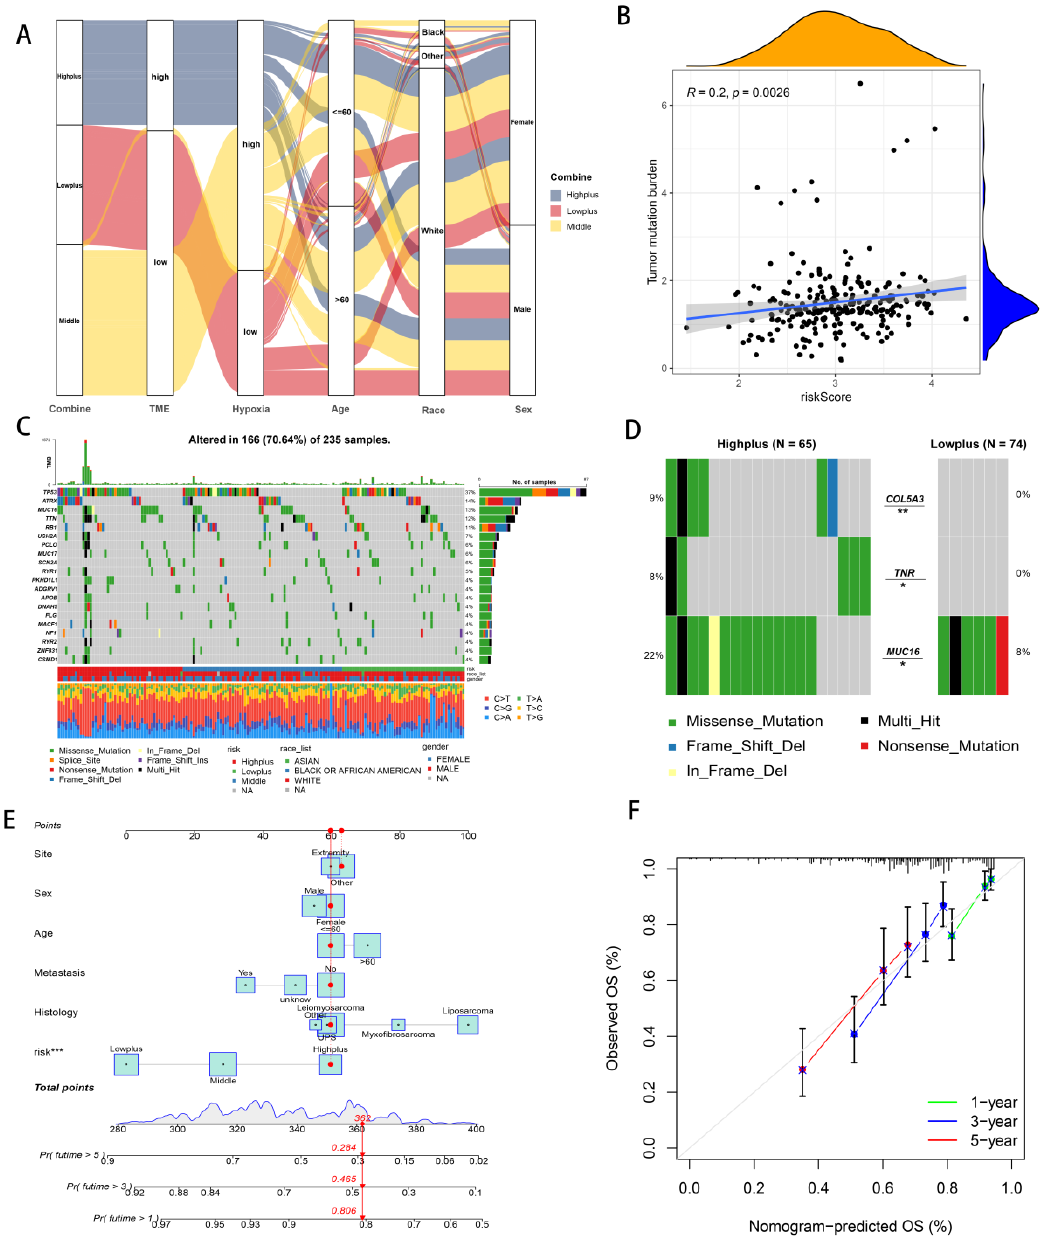
Figure 5. Analyzing Hypoxia-TME information to establish a prognosis model. ( A ) Alluvial diagram illustrating the relationship of Hypoxia/TME-based cluster distribution, different hypoxia and TME risk subgroups and clinical characteristics. ( B ) Relationship between somatic mutation and risk score in training cohort. ( C ) The somatic mutation frequency of three risk groups in TCGA-SARC cohort. ( D ) Significantly different mutant genes between the Highplus and Lowplus groups. ( E ) Nomogram predicting 3-year and 5-year survival rates of STS patients. ( F ) Calibration curve for predicting OS rate of STS patients. ns, p ≥ 0.05; *, 0.01 ≤ p < 0.05; **, 0.001 ≤ p < 0.01; ***, 0.0001 ≤ p <